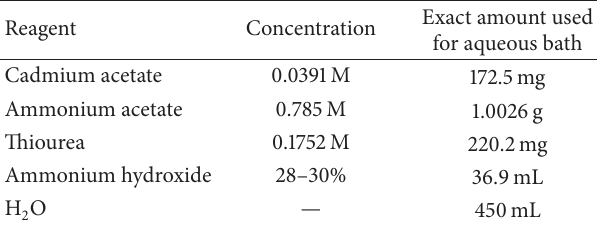
Table 1: Reagents composition of CBD bath used to deposit CdS thin